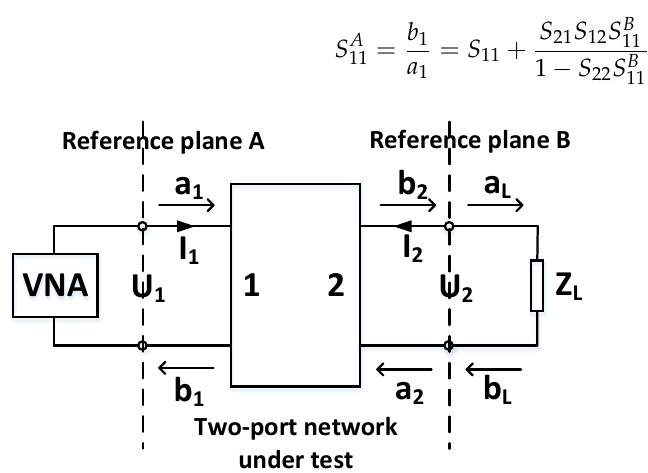
Figure 6. Block diagram of the single port